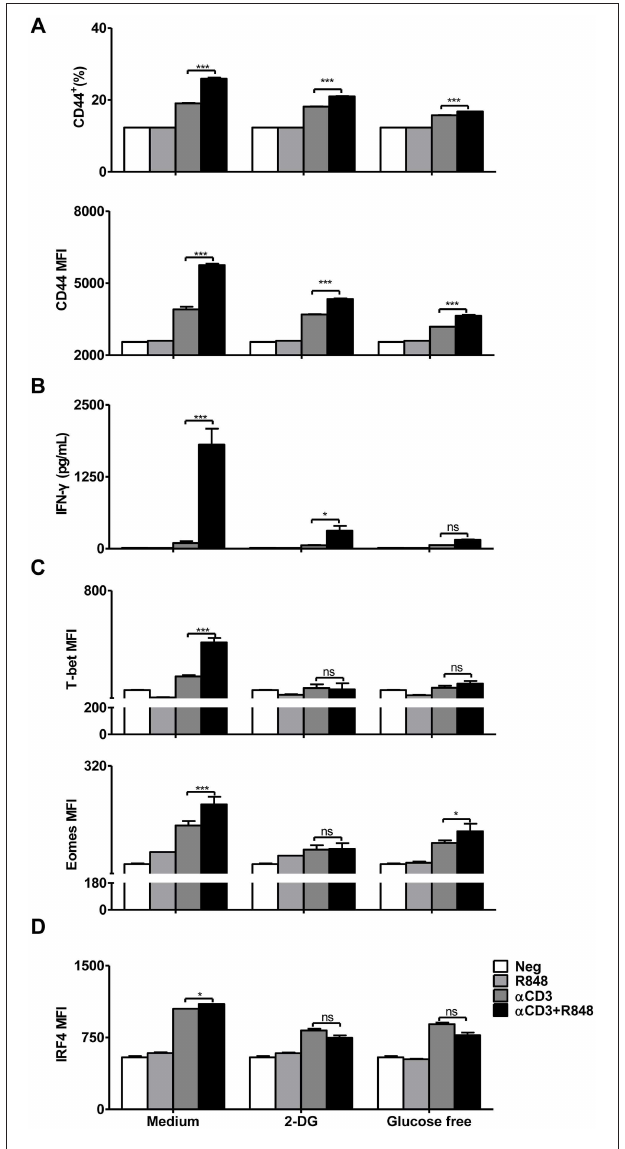
FIGURE 5 | Inhibition of glycolytic metabolism abolishes the functionality of CD8 + T cells. Purified CD8 + T cells were stimulated with α CD3 antibody (5 µ g/mL) or/and R848 (10 µ g/mL) for 24h in the presence of 2DG (2mM) or in the glucose-free medium supplemented with pyruvate. (A) The activation of CD8 + T cells was assessed by staining with an α CD44 antibody. (B) IFN- γ secretion in CD8 + T cells was determined by a specific ELISA. (C) T-bet and Eomes expression in CD8 + T cells was measured by flow cytometry and presented as MFI. (D) IRF4 expression in CD8 + T cells was assessed by flow cytometry. Data are representative of three independent experiments. All data are presented as mean ± SD. (* p < 0.05; *** p < 0.001; ns, not significant) Statistical relevance was determined by Two-way